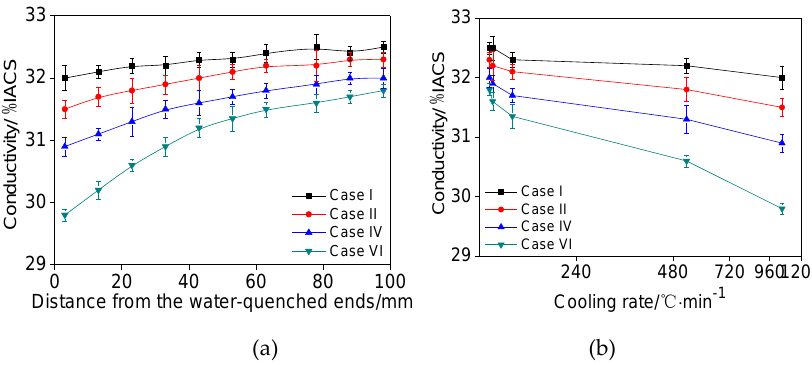
Figure 2. Variation of conductivity vs. ( a ) distance from the water-quenching ends and ( b ) cooling rate.